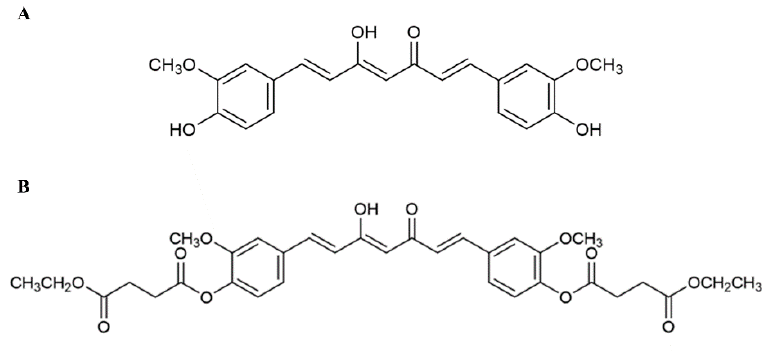
Figure 1. Structure of therapeutic agents used in the present study. ( A ) Curcumin (Cur); ( B ) Curcumin diethyl disuccinate (CurDD).